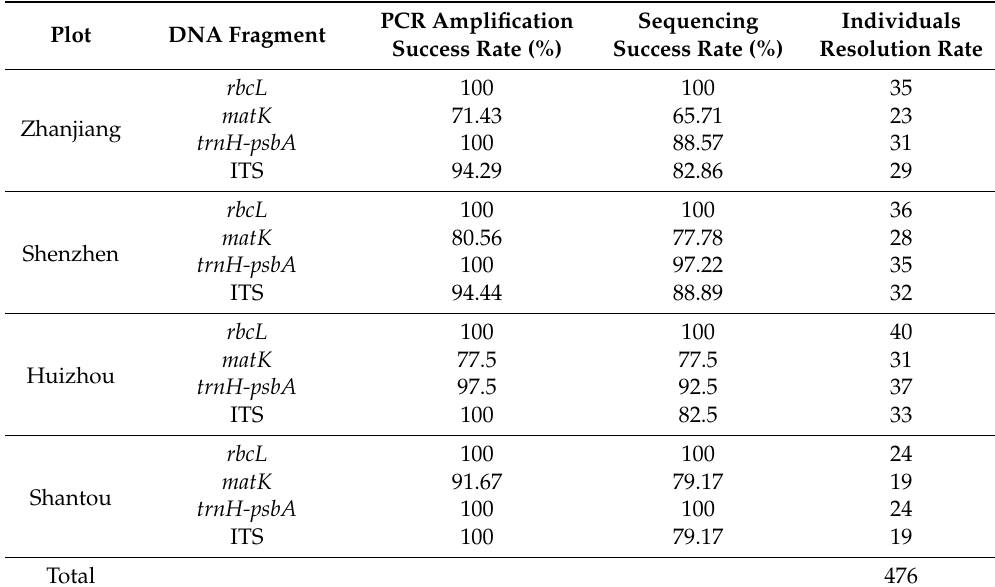
Table 3. The success rates of PCR amplification and sequencing of the four barcoding fragments in the four mangrove